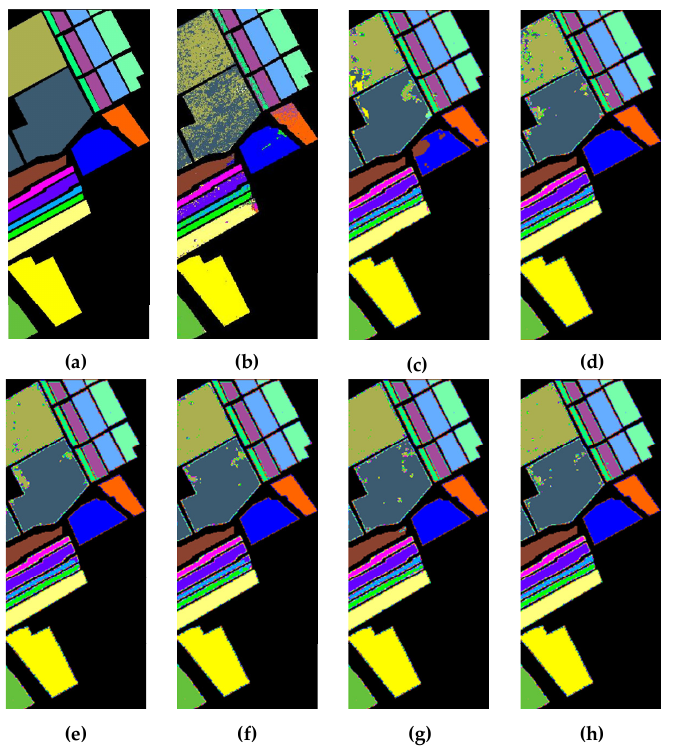
Figure 22. Classification maps acquired by each method for the Salinas Scene dataset: ( a ) ground- truth map, ( b ) SVM, ( c ) 2DCNN, ( d ) 3DNN, ( e ) SSRN, ( f ) HybridSN, ( g ) SSAN, ( h ) proposed TSS- FAN.